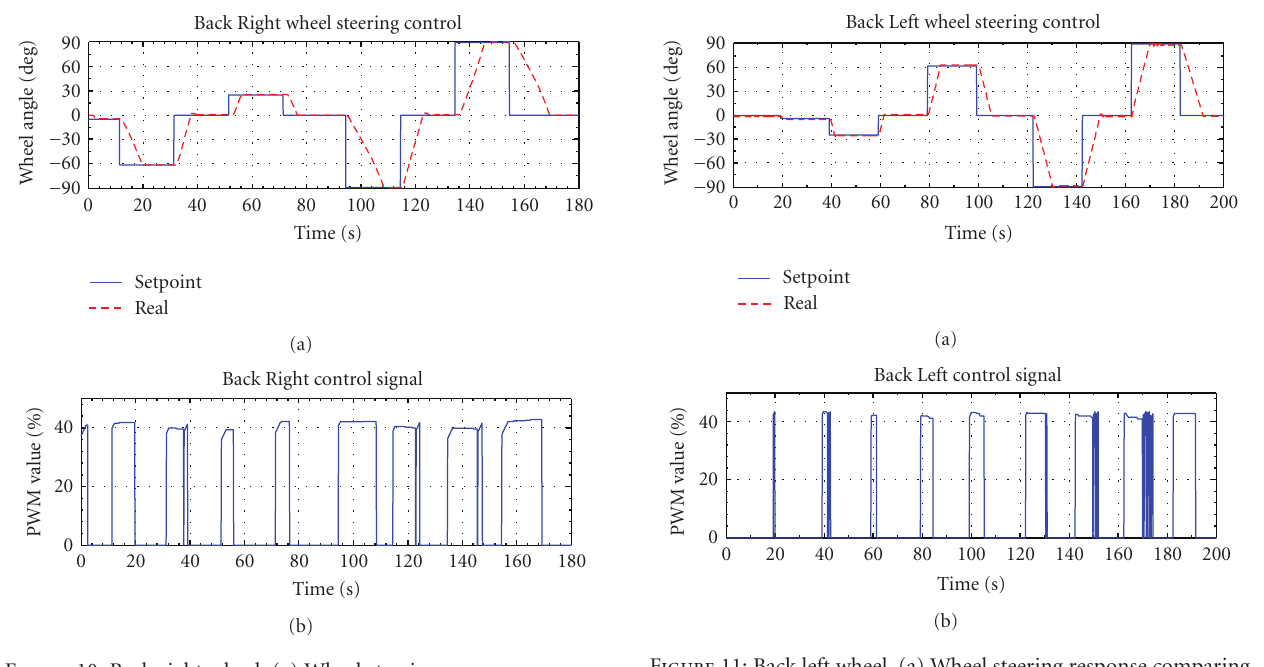
Figure 10: Back right wheel. (a) Wheel steering response compar- ing desired and real position. (b) Dynamic of PWM applied.